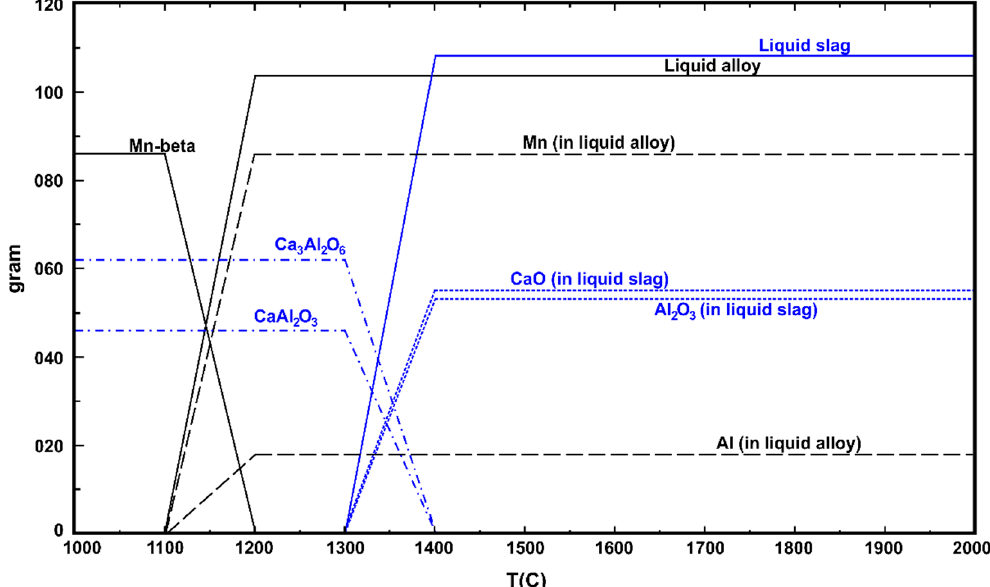
Figure 5. Calculated equilibrium conditions for the interaction of 46 g Al with a 55 g CaO-111 g MnO slag (FactSage ver. 7.3.).